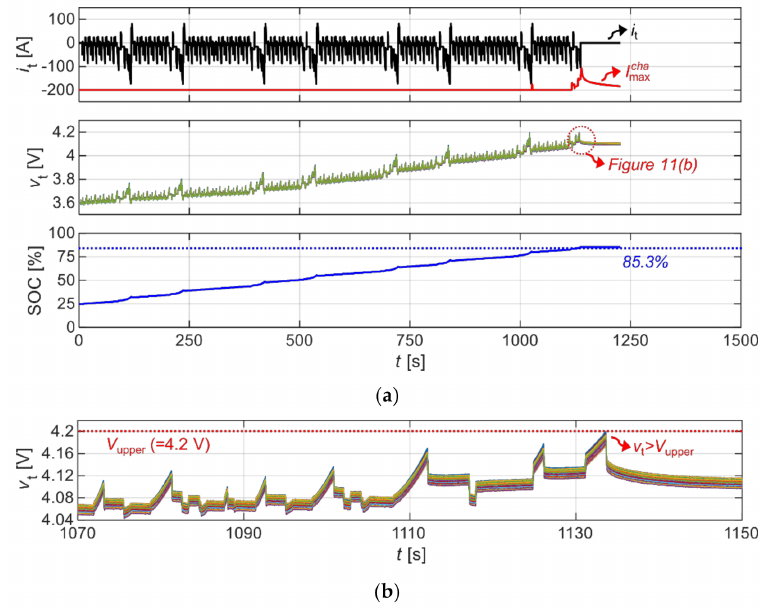
Figure 11. Experimental results for the counterpart (neglecting cell inconsistencies): ( a ) i t , v t , and SOC; ( b ) the enlarged v t of the cells during 1070.0–1150.0